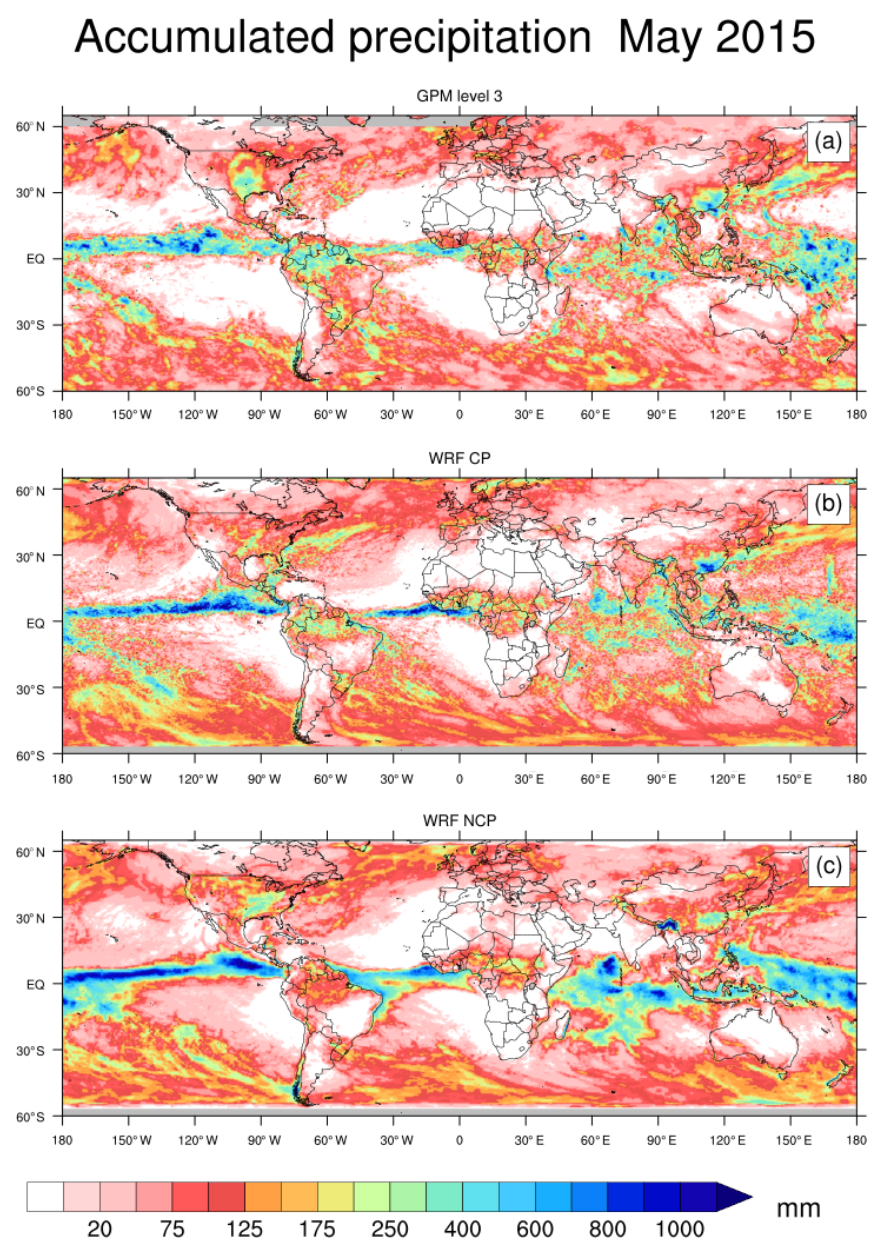
Figure 6. Accumulated precipitation (mm) during May 2015: (a) Global Precipitation Mission (GPM) level 3 data set, (b) CP simulation, and (c) NCP simulation. Grey shaded areas indicate a lack of coverage in the GPM data or the simulations. The model data are interpolated to the GPM